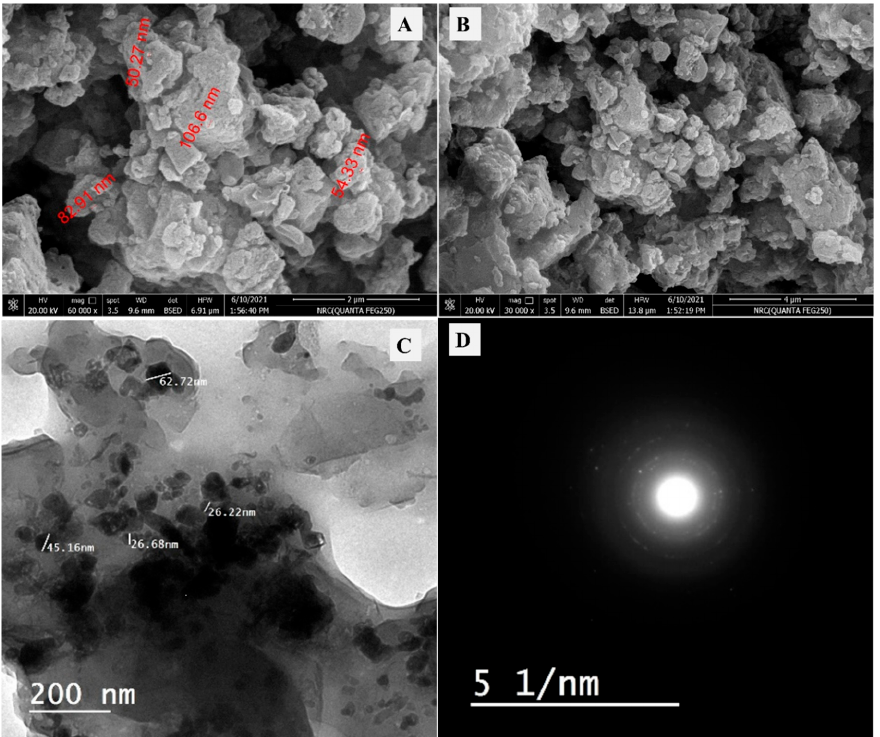
Figure 1. ( A , B ) SEM images of ZnNiO@PANE nanocomposite at different sample areas, ( C ) TEM of ZnNiO@PANE nanocomposite, ( D ) SAED of ZnNiO@PANE nanocomposite.